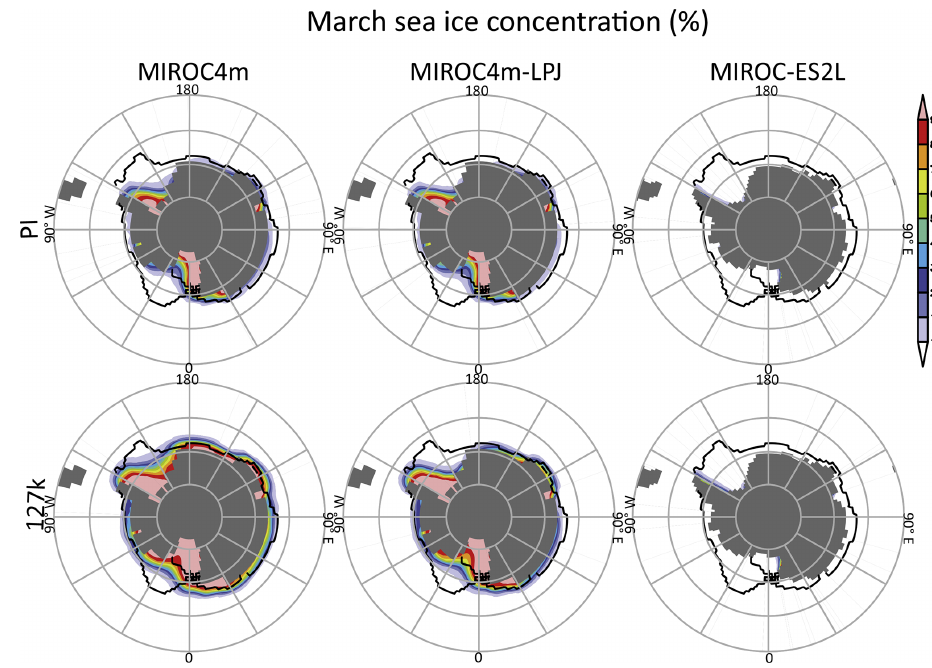
Figure 12. Same as Fig. 10 but for SH March sea ice concentration (%).